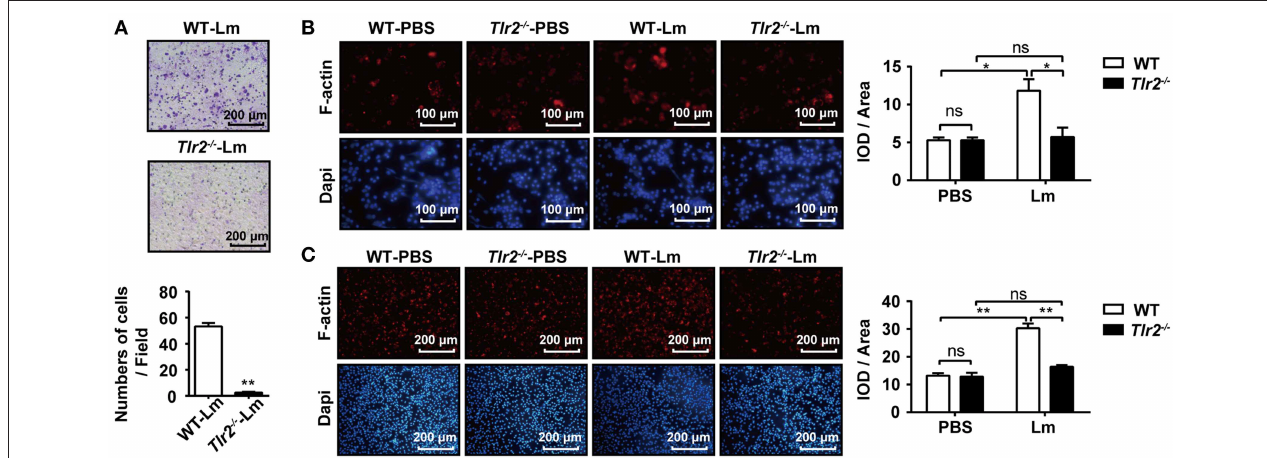
FIGURE 3 | TLR2 promotes macrophage mobility. (A) WT and Tlr2 − / − mice were i.p. infected with 1 × 10 6 CFU of Lm for 1 day. The mobility of peritoneal macrophages was measured using a transwell chamber migration assay. (B,C) Macrophages were isolated from 1 day infected or uninfected WT and Tlr2 − / − mice, and then seeded in 12-well plates at a density of 2 × 10 5 cells/well. After 1h, cells were fixed, permeabilized, and stained with rhodamine-conjugated phalloidin and DAPI (B) . WT and Tlr2 − / − macrophages were infected with Lm in vitro for 1h. F-actin was stained with rhodamine-phalloidin (C) . The ratio of integrated optical density (IOD) to area of interest was calculated to assess the level of F-actin. Red, F-actin; blue, Dapi. One representative of three independent experiments. Data are presented as the mean ± SEM of three independent experiments. * p < 0.05, ** p <